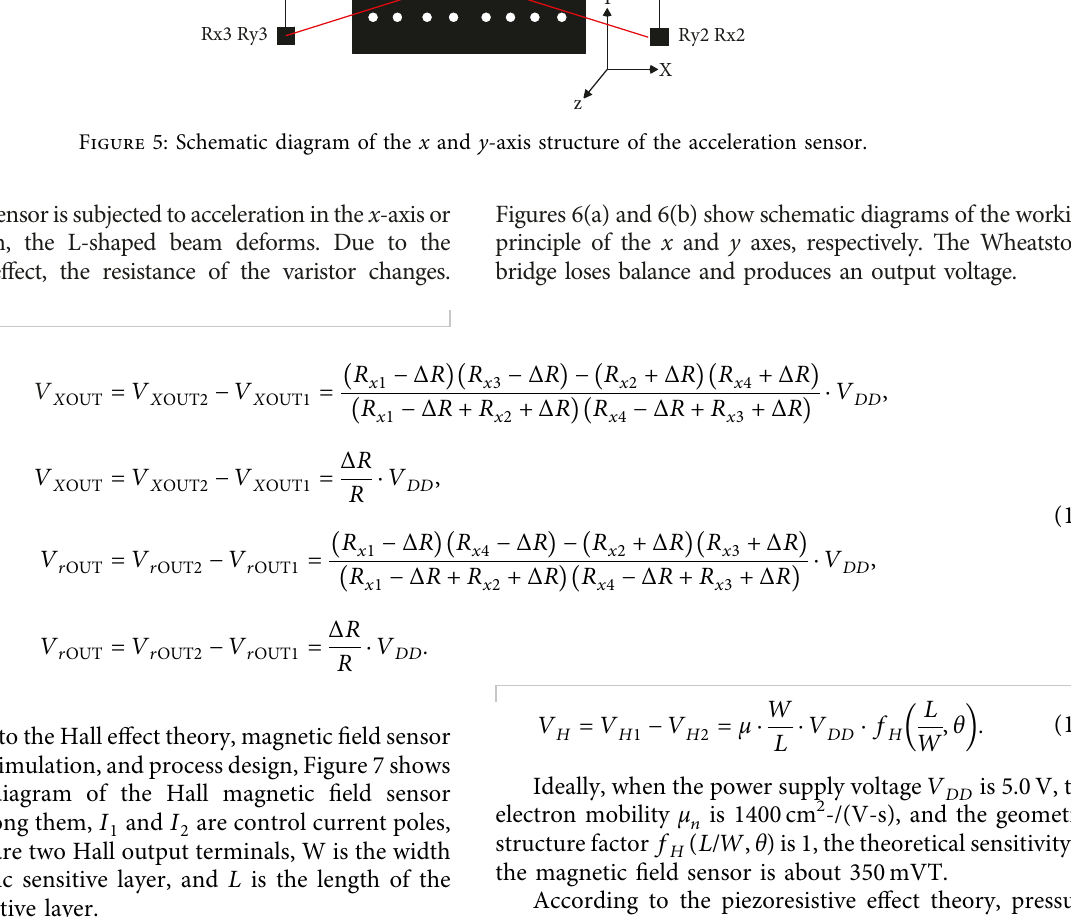
0 and (b) az (cid:31) ≠